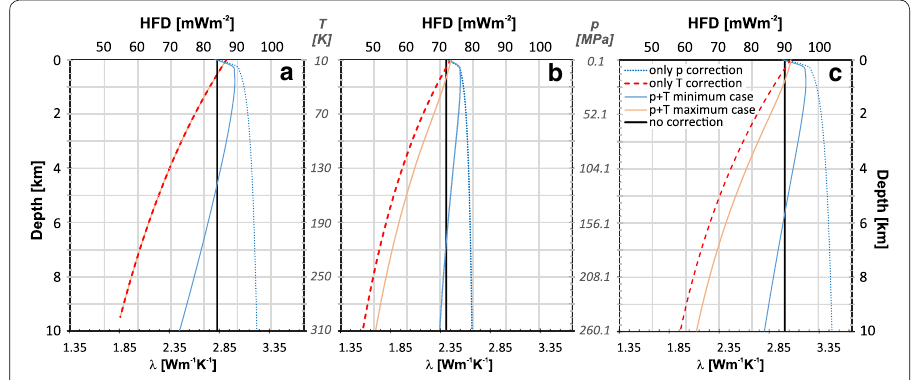
Fig. 8 Effect of p / T corrections on thermal conductivity ( λ ) and determined heat‑flow density (HFD), assuming a T gradient of 30 °C km − 1 and a p gradient of 26 MPa km − 1 for a sedimentary rock with λ W m − 1 K − 1 , b for a mafic type of rock ( λ applying no correction, only pressure correction, only T correction and combined p / T corrections [ λ ( p the minimum and maximum case (see Table